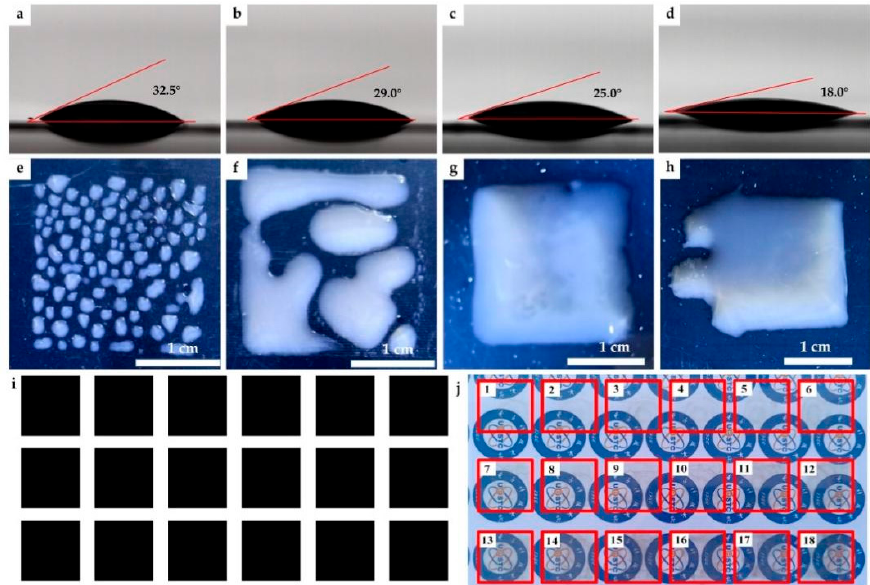
Figure 2. ( a – d ) CA images of sample A–D; ( e – h ) photographs of the printed patterns without heat treatment with samples of A–D on PET; ( i ) designed square patterns with size of 2 cm × 2 cm by computer; ( j ) photographs of printed patterns with 1–18 layers, respectively, after heat treatment.